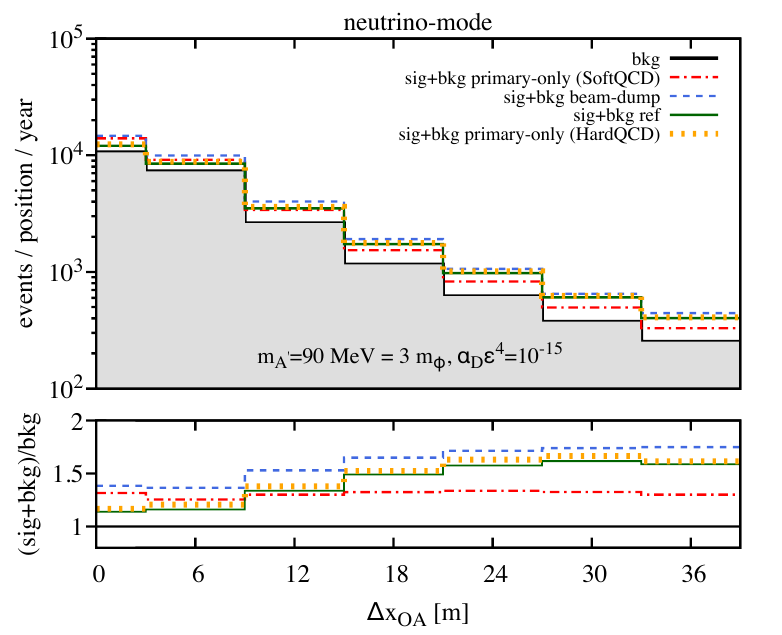
Figure 12 . Same as figure 1, but including the result of ref. [13] in solid green, and our own primary-only (HardQCD) sample in dotted